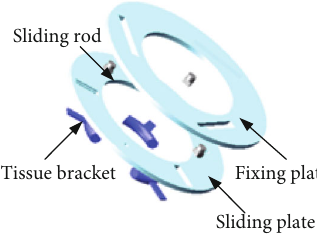
Figure 4: The fi xed disk